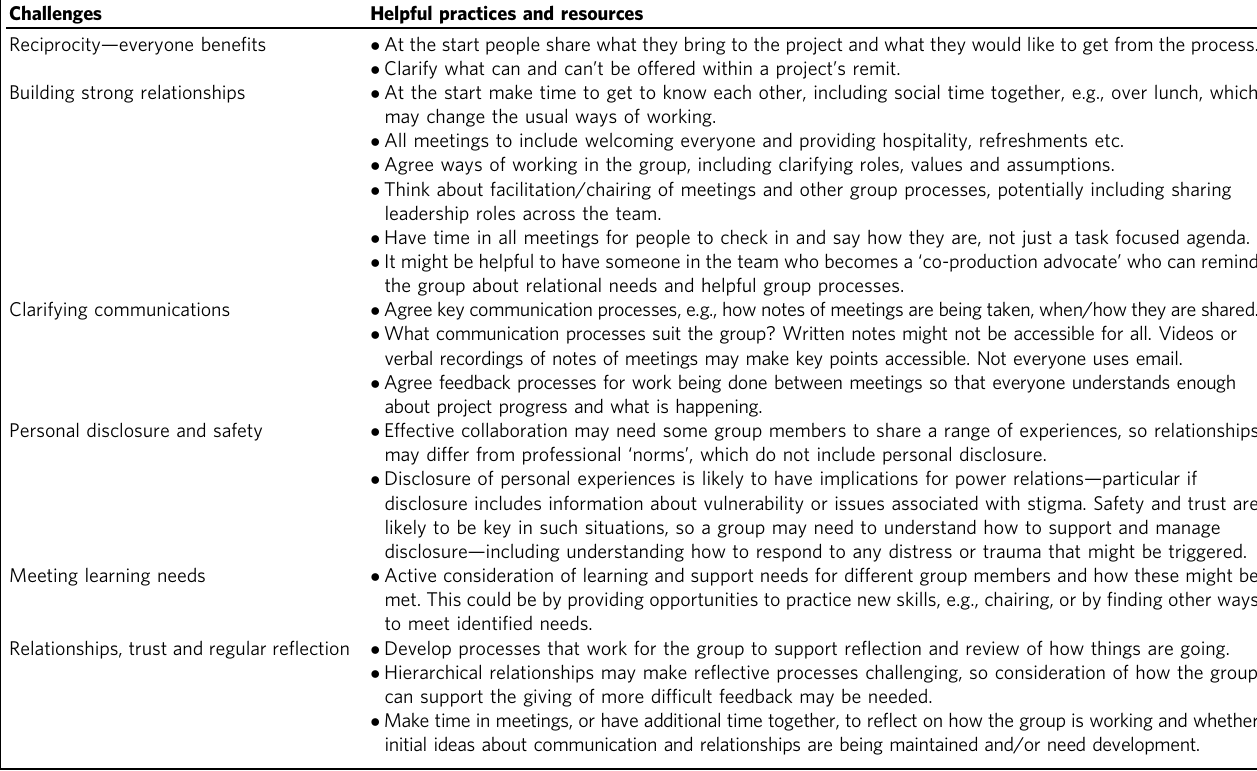
Table 2 Navigating challenges relating to communication and relationships. Challenges Helpful practices and resources Reciprocity — everyone bene fi ts Building strong